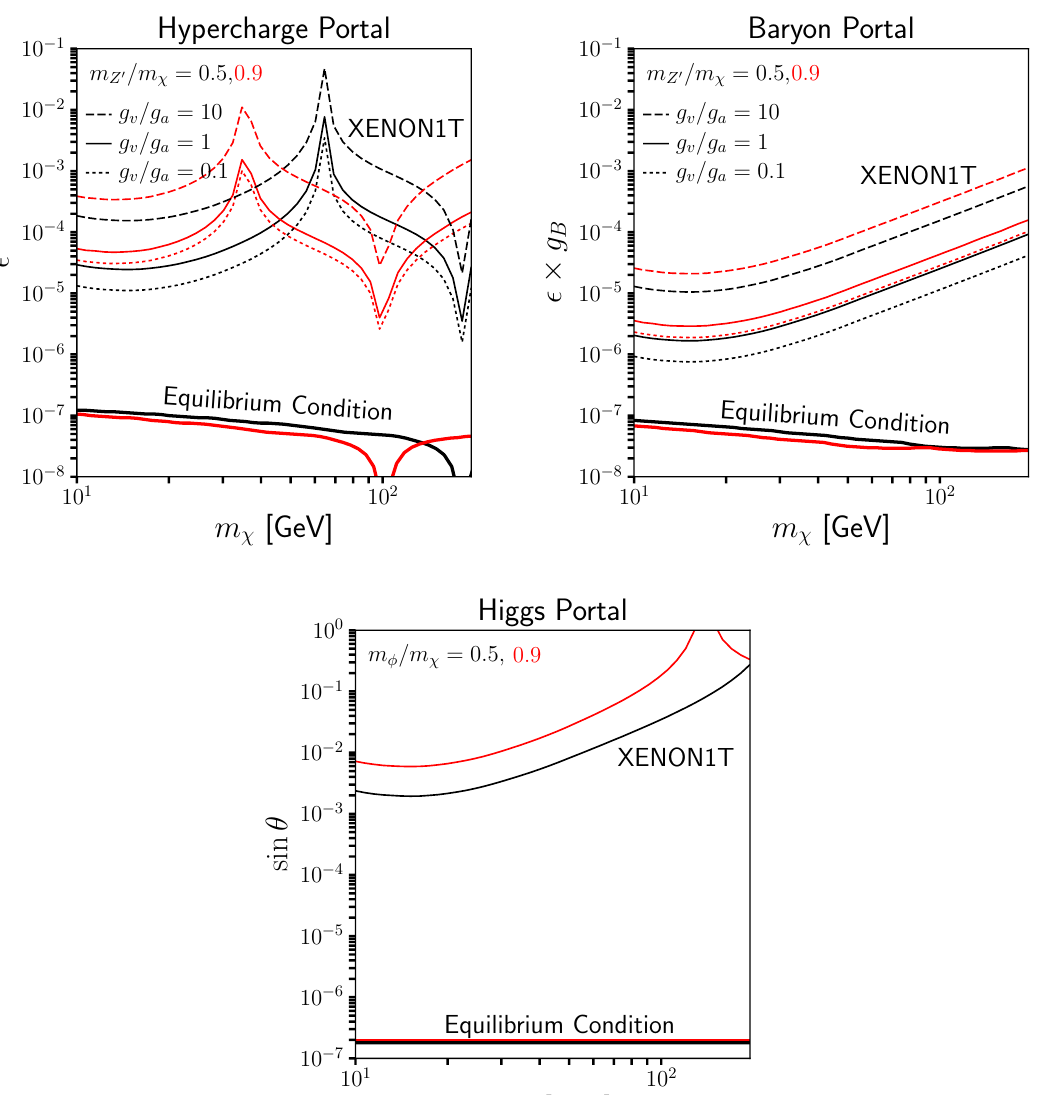
Figure 11 . The thick solid lines denote the minimum values of portal coupling that are required to maintain equilibrium between the hidden and SM sectors leading up to the time of dark matter freeze-out. In the case of the Higgs portal, we plot this condition for the case of v (cid:30) = 100 GeV, where v (cid:30) is the hidden sector vev. The thin lines represent the constraints from XENON1T, for the case of spin-independent scattering between dark matter and nuclei. Note that future experiments with sensitivity near the \neutrino (cid:13)oor" will improve on these constraints by a factor of (in terms of the quantities shown on the y -axes of this (cid:12)gure).